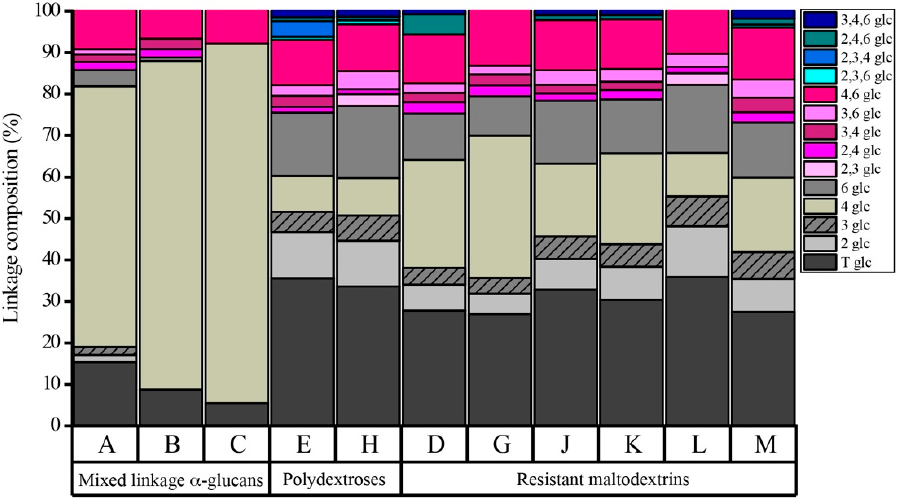
Figure 1. Glycosidic linkage composition of glucans, determined by the partially methylated alditol acetate method with gas chromatography-mass spectrometry. Shades of brown represent non-branched regions; shades of pink represent single branches and blue represents multiply-branched glycosyl residues.